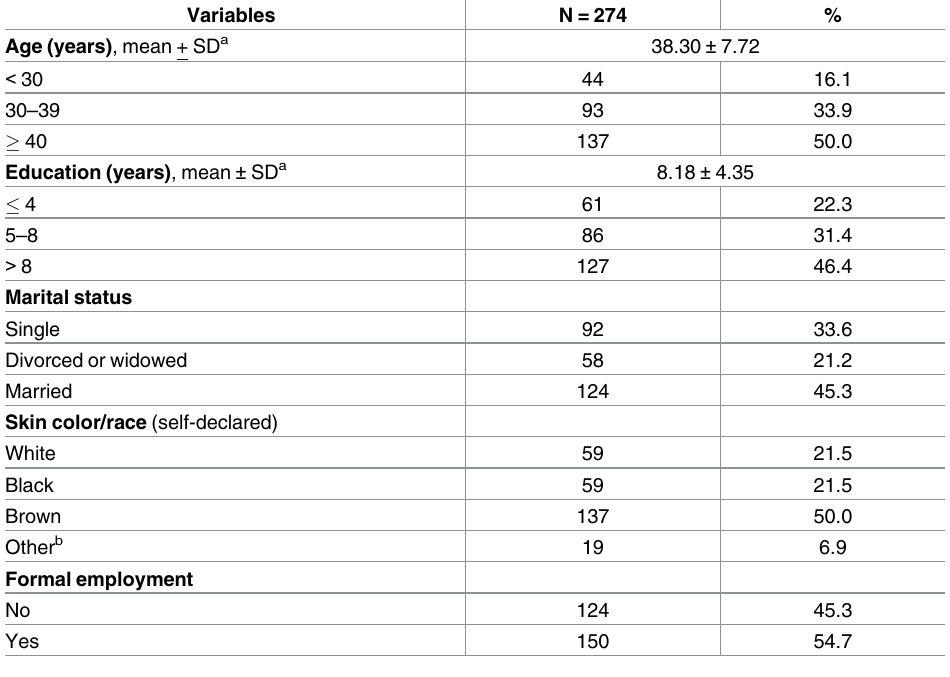
Table 1. Sociodemographic characteristics of WLWHA in Central Brazil, 2015–2016.